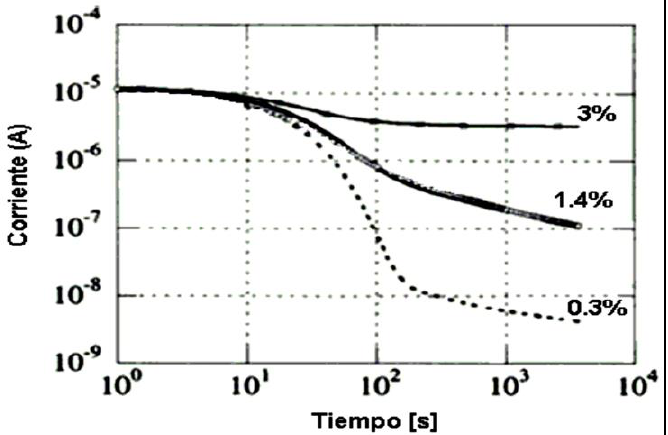
Figura 12: Variación de la corriente de polarización para varios contenidos de humedad del papel.